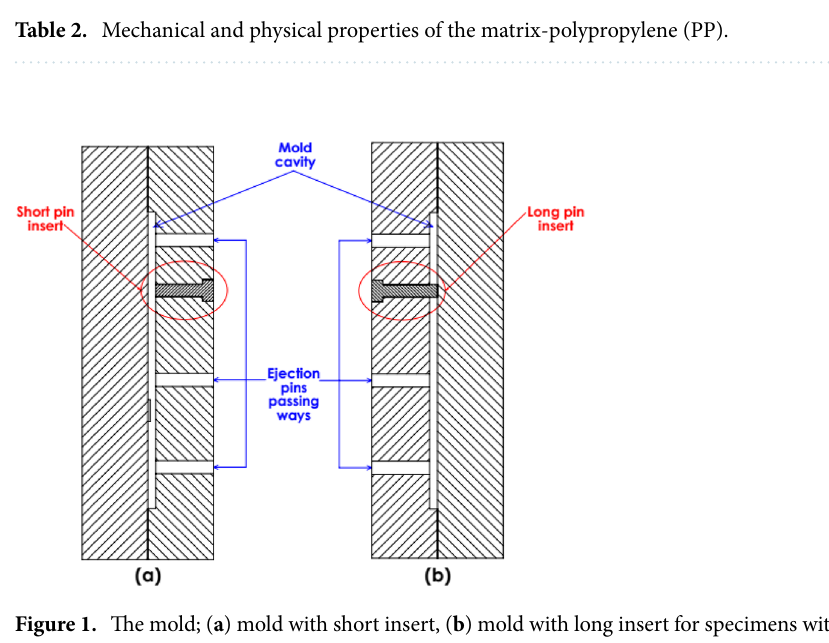
Figure 1. The mold; ( a ) mold with short insert, ( b ) mold with long insert for specimens with molded-in